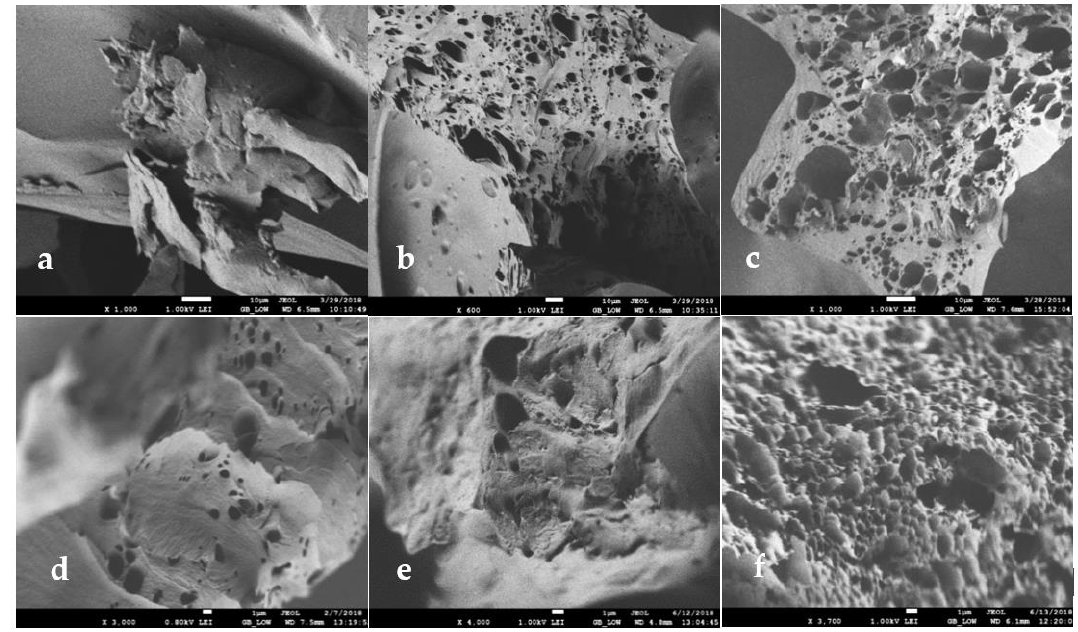
Figure 3. SEM images of freeze-dried HPMC-based MBGs. ( a ) System A prepared without organic components; ( b ) System A prepared with isooctane; ( c ) System A prepared with 0.1 M AOT µ